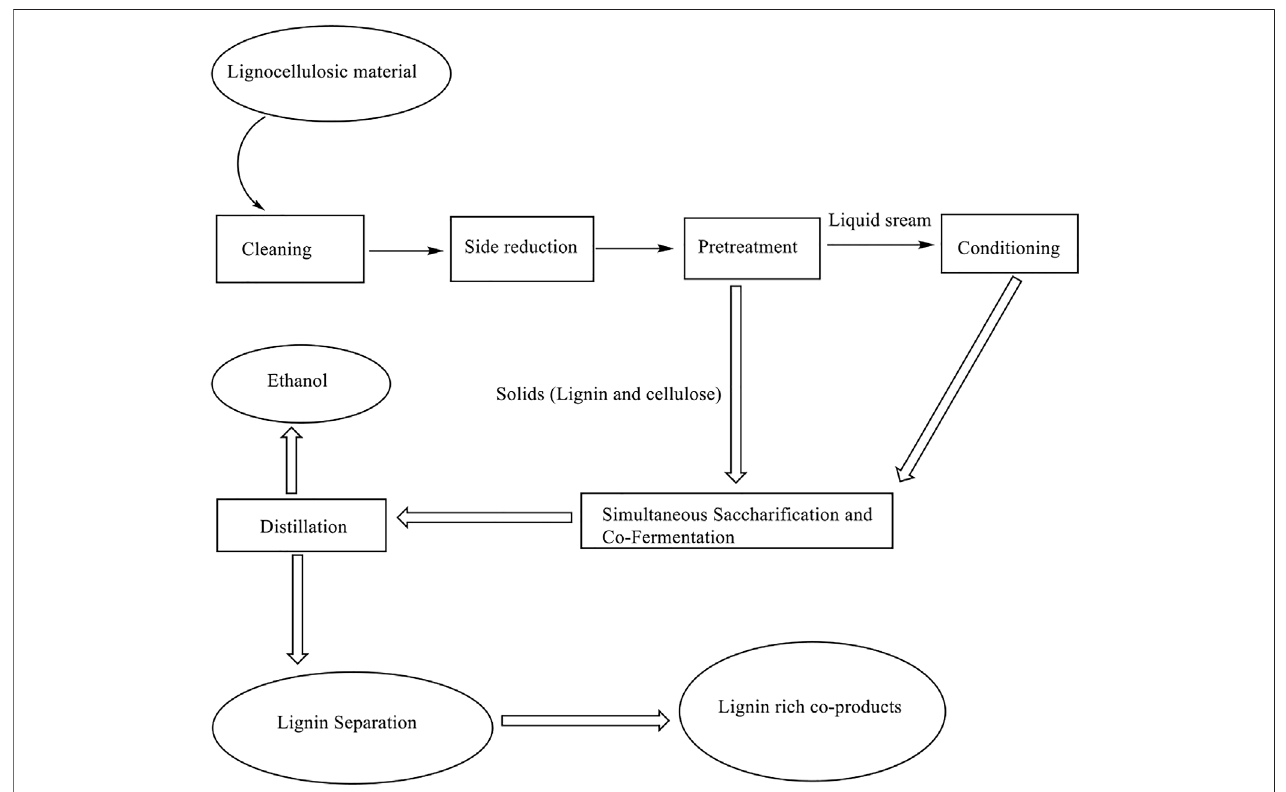
FIGURE 2 | Illustration of common ethanol production